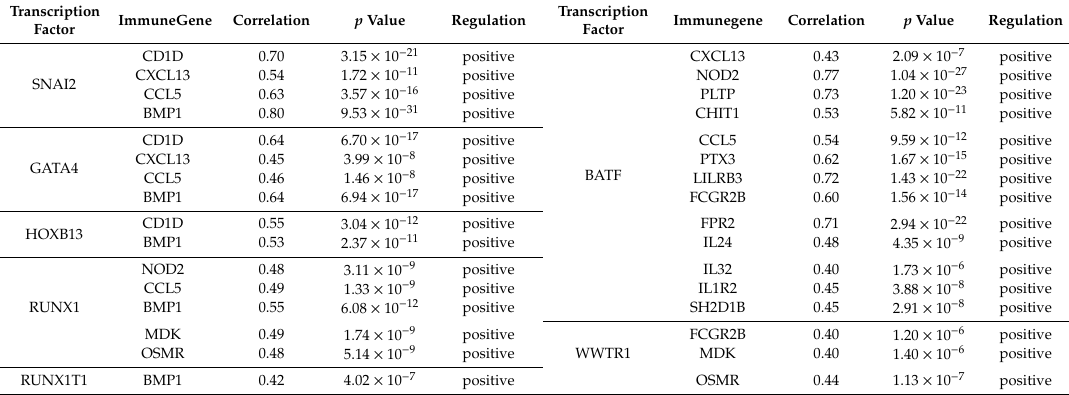
Table 1. Seven immune transcription factors screened for gene regulation. Detailed information of each transcriptome and its regulatory genes.